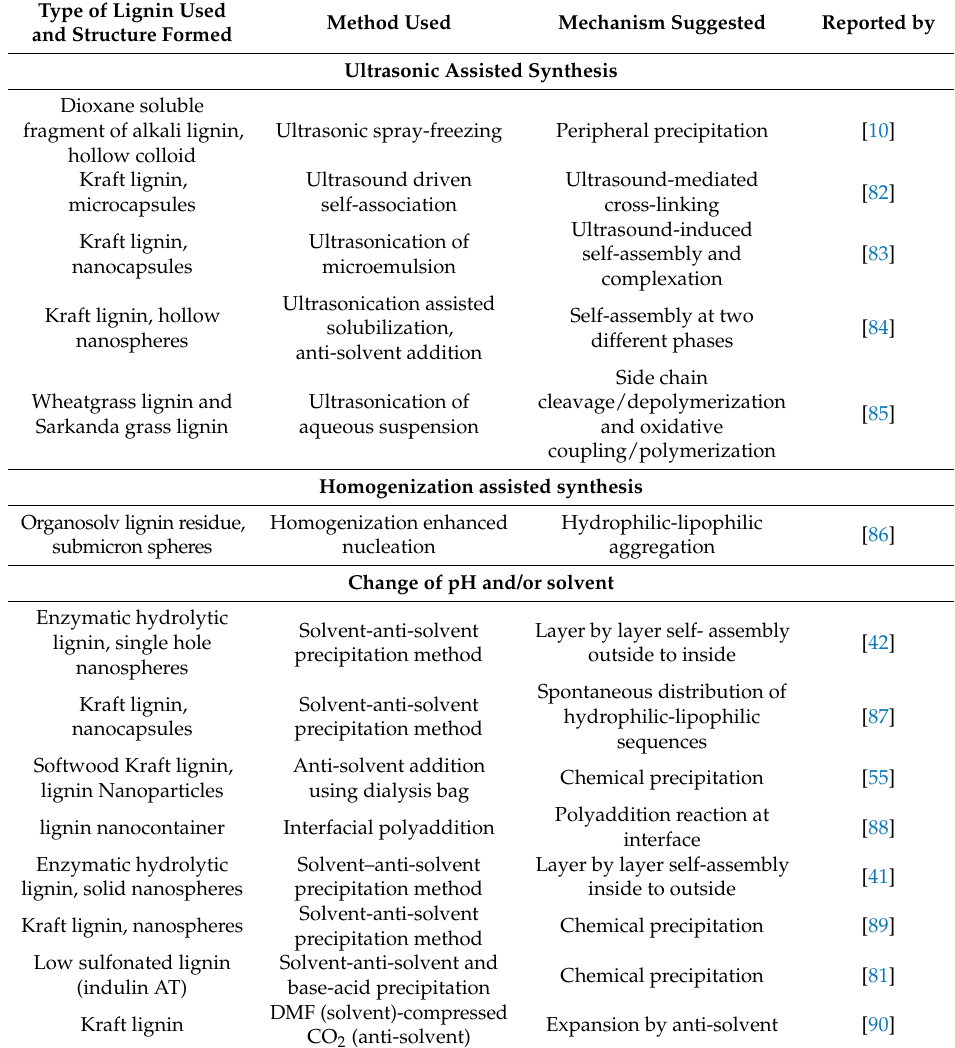
Table 2. Information from some of the latest reports on the synthesis of hollow nanoparticles/ nanocapsules of